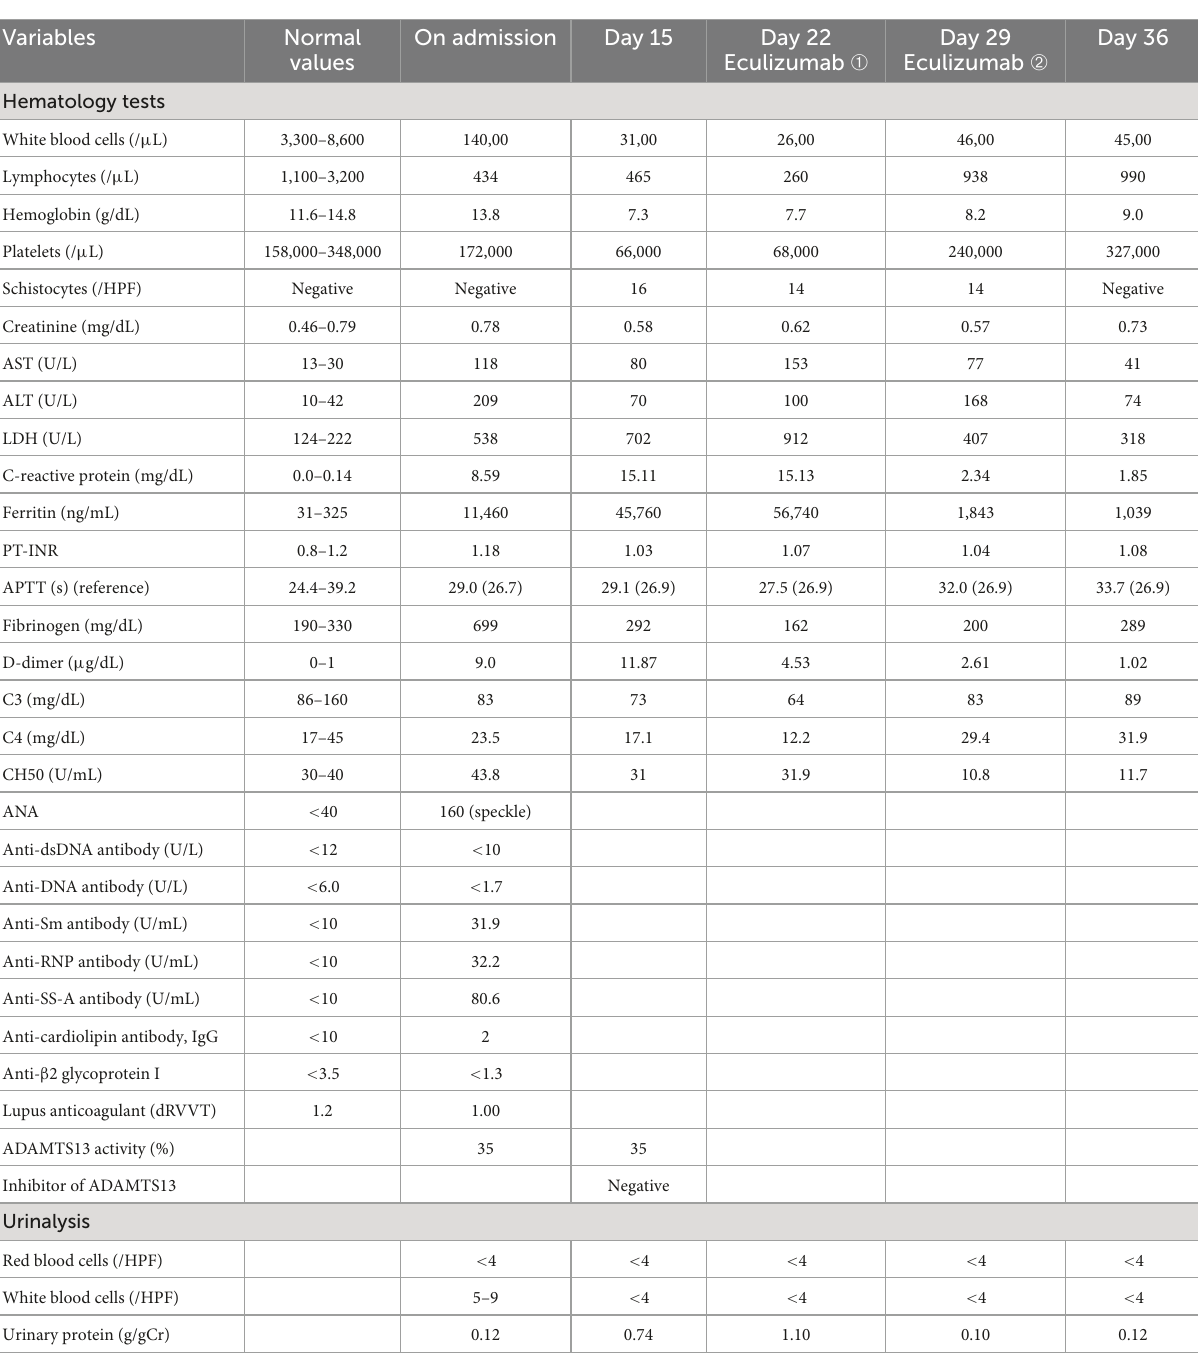
TABLE 1 Main laboratory